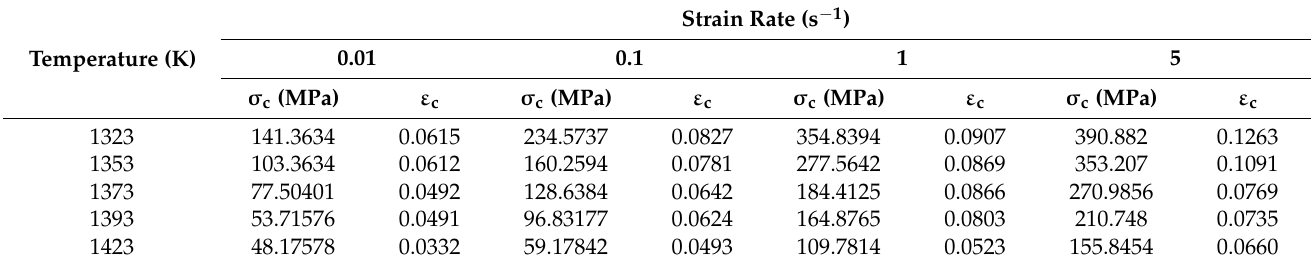
Figure 10. The curve of dθ/dσ - σ.